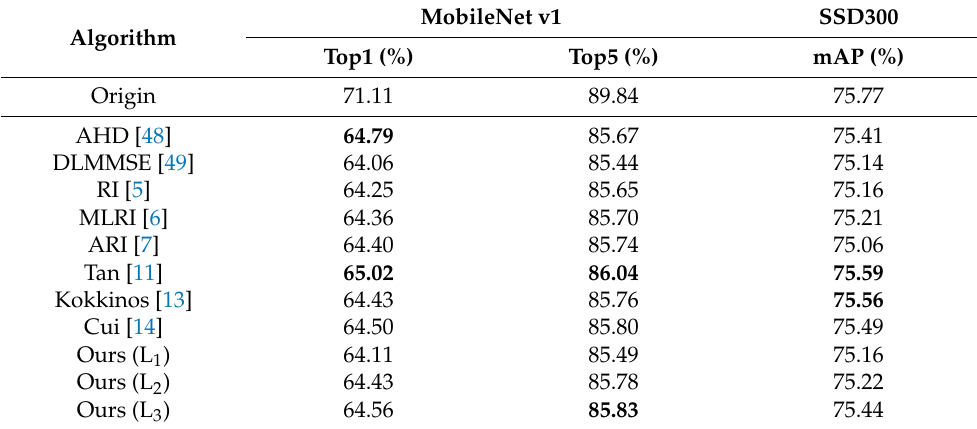
Table 5. The accuracy of classification and detection tasks connected with demosaicking methods. The ‘Origin’ item indicates the original accuracy of the pre-trained model MobileNet v1 and SSD300. The bolded two methods in each section are those that achieve better performance among all